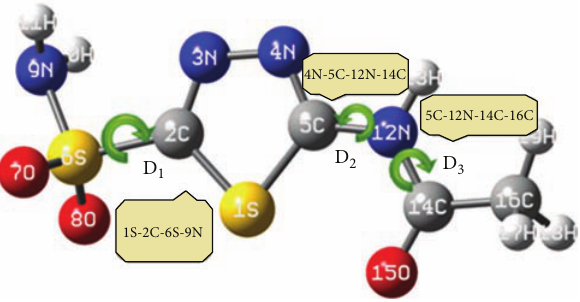
Figure 1: The most stable geometry, atom numbering, and searched dihedral angles of